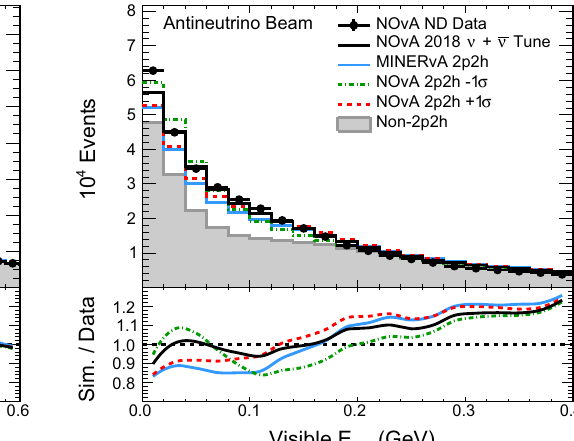
with +1 and − 1 σ shifts from the 2p2h ( q 0 , |(cid:2) q | ) response systematic uncertainty shown in Fig. 11, respectively. Also shown in solid blue is the result of replacing our tuned 2p2h with MINERvA’s tuned 2p2h prediction.TheshadedgrayhistogramrepresentstheGENIEprediction for non-2p2h interaction channels